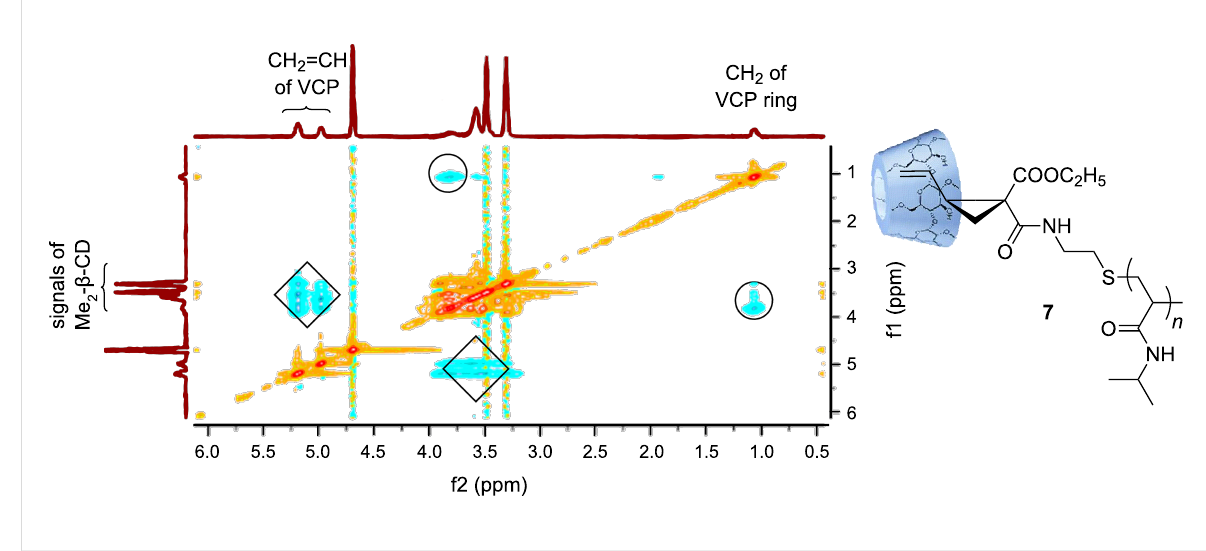
Via condensation of the amino end group of 3 with the carboxyl group of 4 the corresponding macromonomer 5 with M n = 11540 g/mol und T g = 129.1 °C was obtained. The 1 H NMR spectrum confirms the existence of a vinylcyclopropane unit by the presence of the multiplets at δ 1.48–1.61 ppm and δ 4.98–5.19 ppm, assignable to the CH of the cyclopropane ring and of the vinyl group, respectively. The FTIR spectrum shows